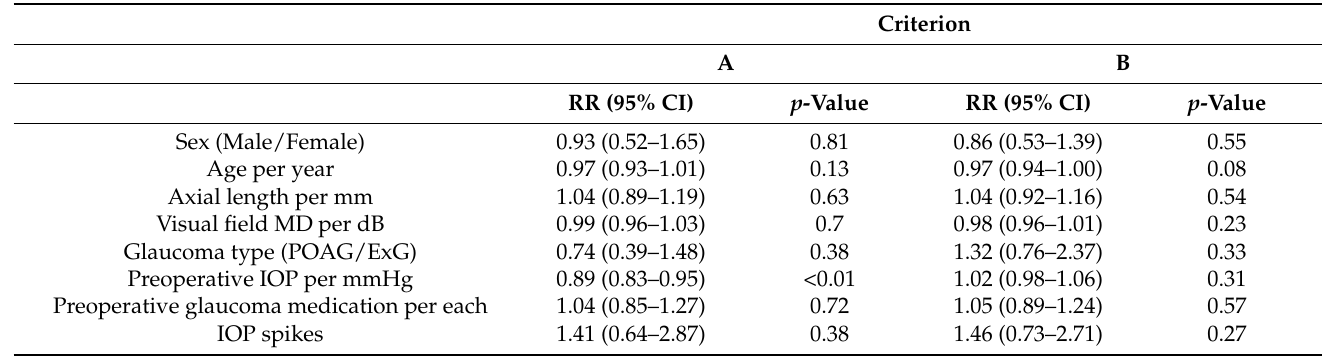
Table 4. Multivariable analysis to identify prognostic risk factors for failure using Cox proportional hazards regression